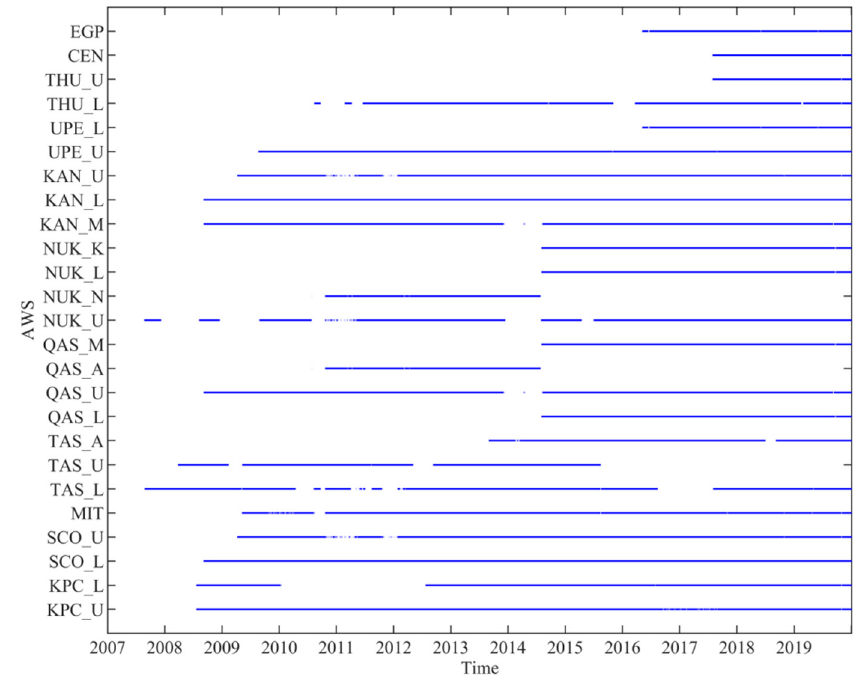
Figure 2. Observation periods for AWSs used in this study.